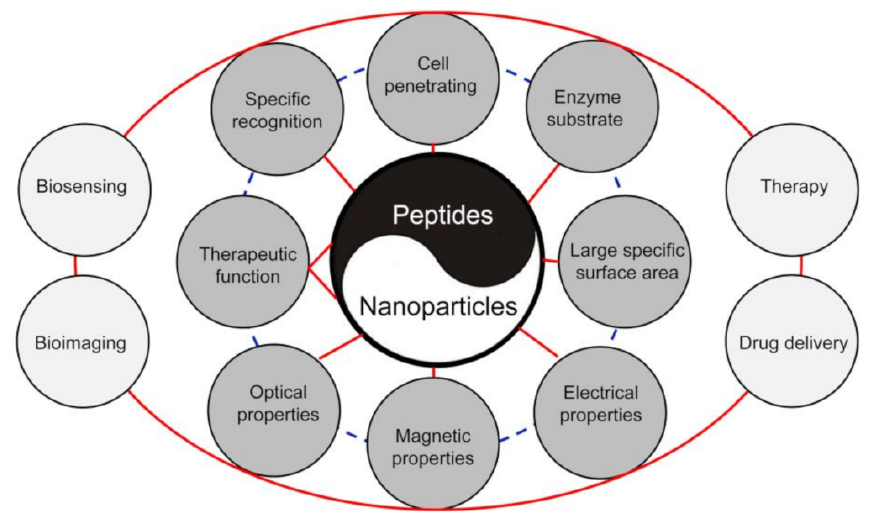
Figure 1. Schematic illustration of the effects of properties of peptide functionalized NPs on bioanalyt- ical and biomedical areas including biosensing, bioimaging, drug delivery, and therapy. Combination of the biological properties of peptides and unique physicochemical properties of NPs can generate excellent nanosensing platforms with high sensitivity and specificity and nanotheranostics with high tumor-targeting